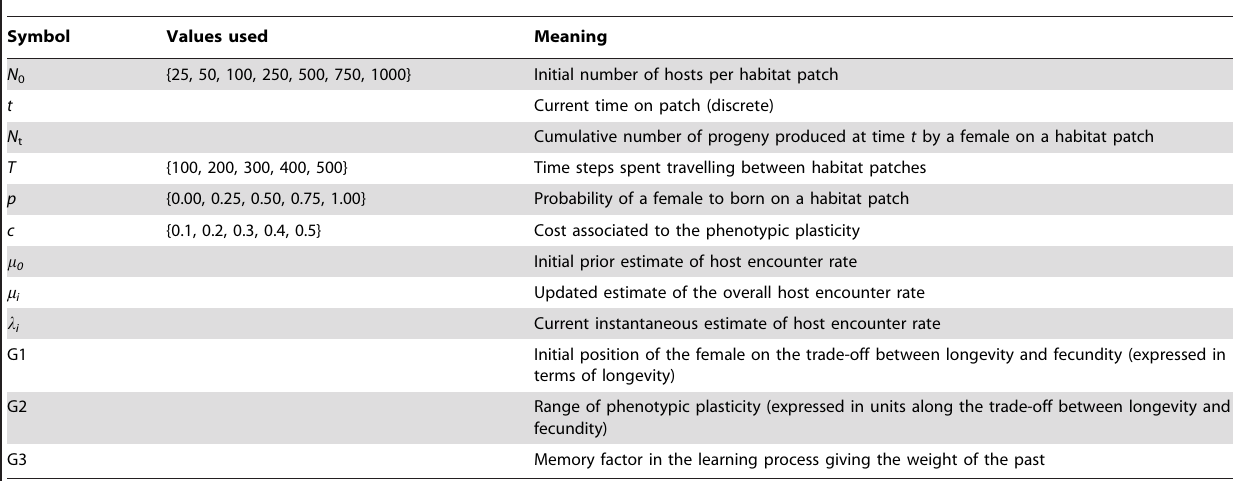
Table 1. Definition of the model parameters with the values